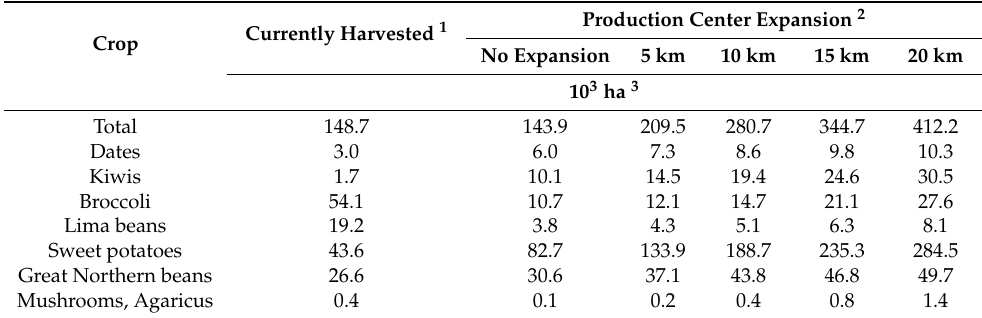
Figure 7. Suitable agricultural land for mushrooms (agaricus) in Chester County, Pennsylvania. Table 2. Current agricultural land area and potential agricultural land area suitable for the production of nutrient dense fruits and vegetables.